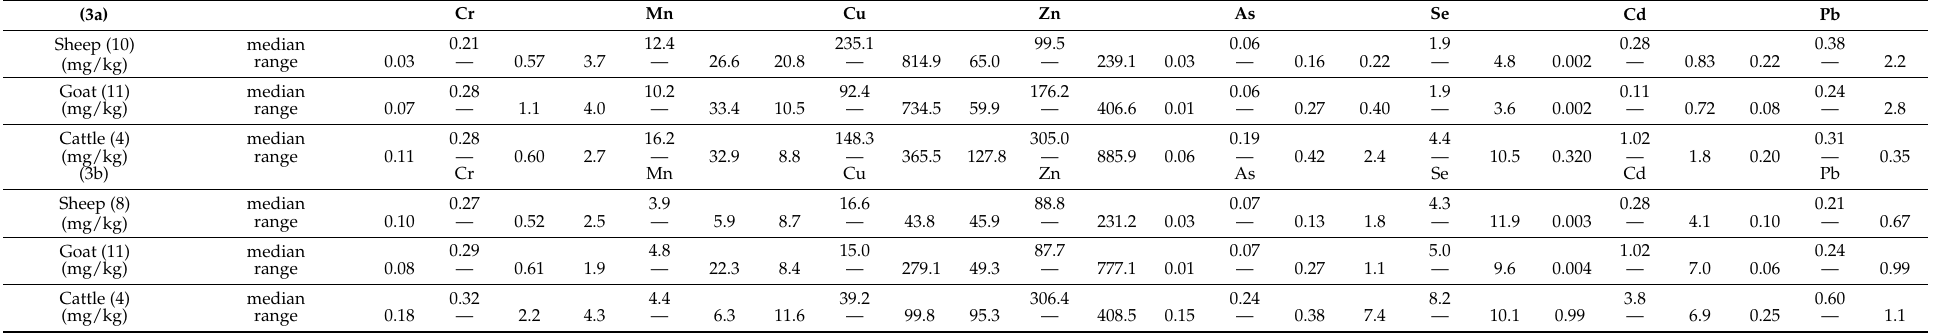
Table 3. Metal concentration in liver (3a) and kidney (3b).